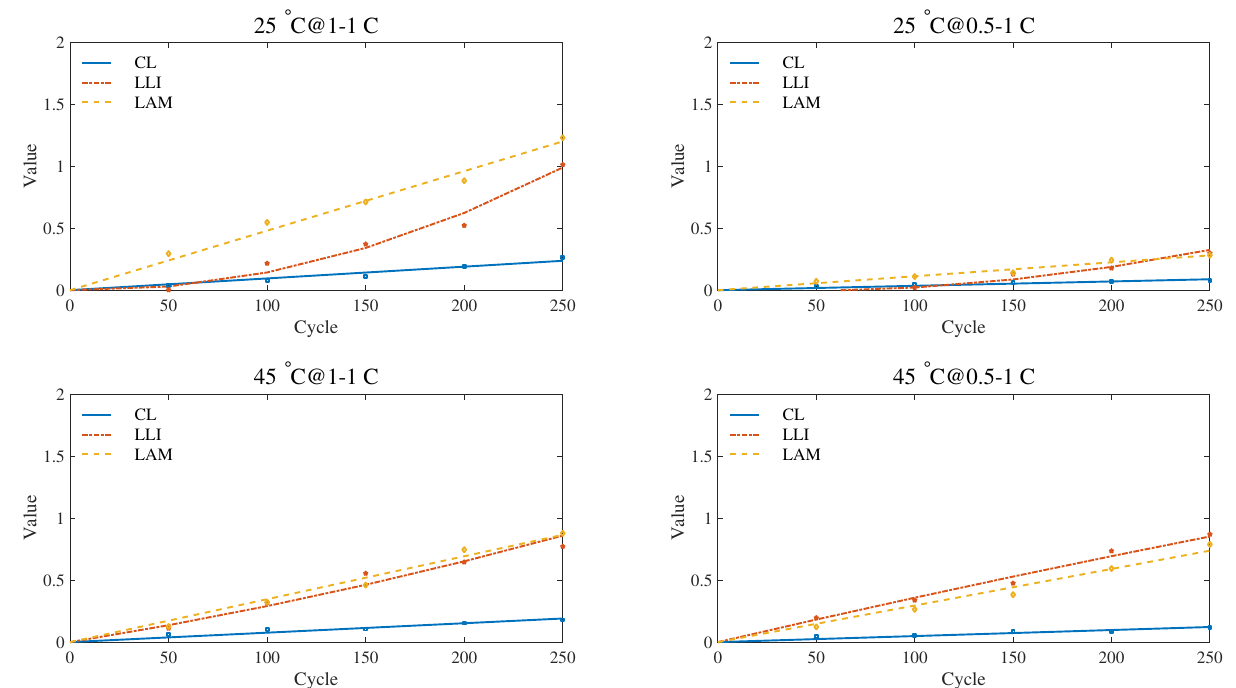
Figure 12. Quantitative results of degradation modes of lithium-ion batteries under different conditions, using 500 mA current excitation and 80% SoC for EIS